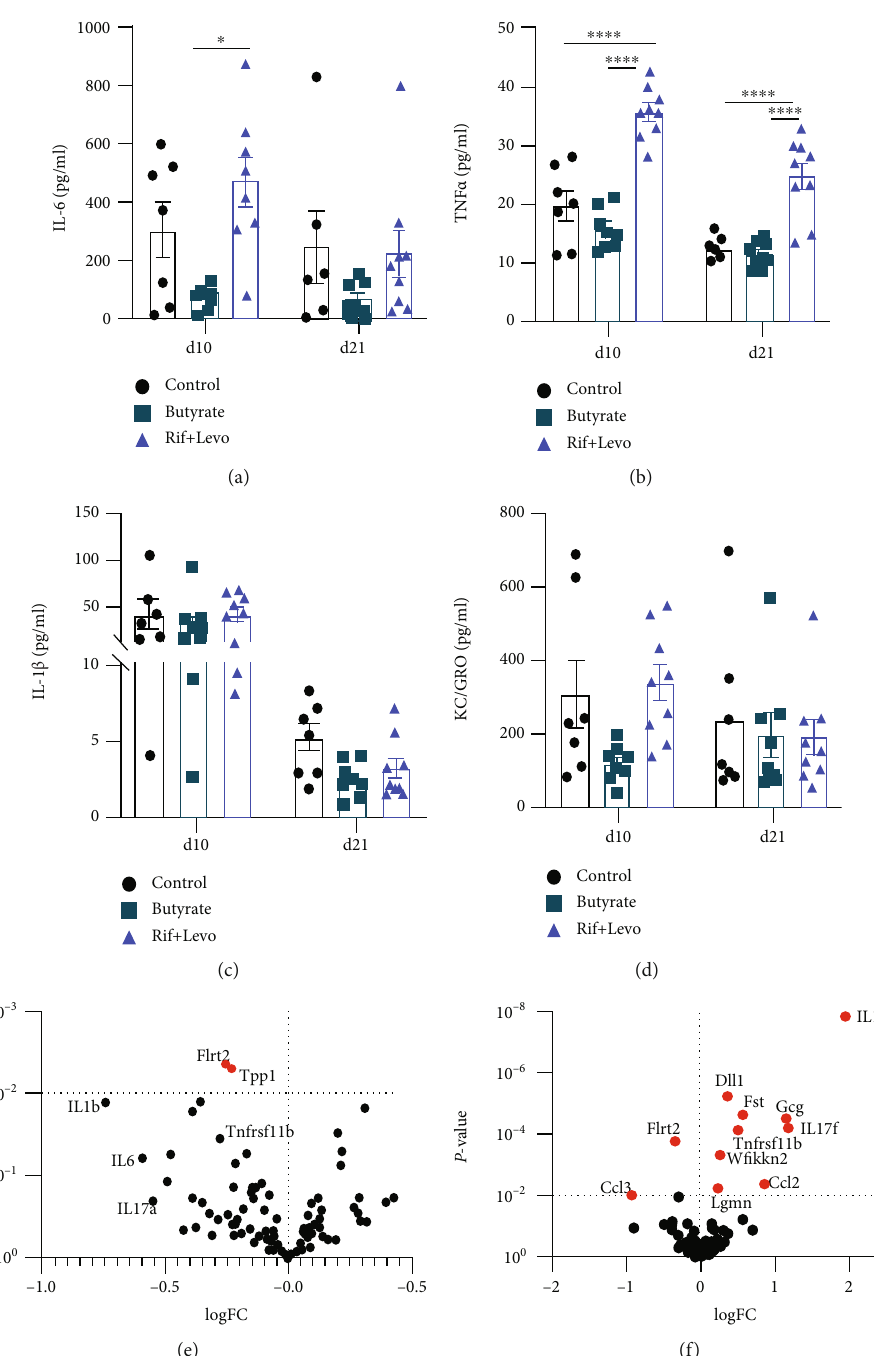
Figure 4: Butyrate induces a reduction of proin fl ammatory mediators, whereas rifampicin and levo fl oxacin increase proin fl ammatory and bone-preserving markers in serum. A variety of (pro-) in fl ammatory cytokines in serum of mice were assessed 10 days and 21 days following osteotomy using a multiplexed cytokine array and Olink targeted proteomics to investigate systemic biomarkers in serum of mice. Serum concentrations of (a) IL-6, (b) TNF α , (c) IL-1 β , and (d) of KC/GRO (murine IL-8 homologue) in the absence and presence of butyrate and Rif + Levo , respectively, 10 days and 21 days after osteotomy. Data shown are means ð n = 7 ‐ 9 Þ ± SEM . Di ff erential expression of 92 biomarkers in (e) butyrate-treated mice compared to control mice and in (f) Rif + Levo -treated mice compared to control mice. Signi fi cance threshold p < 0 : 01 . Signi fi cantly changed biomarkers are labelled in red. Flrt2 =leucine-rich repeat transmembrane protein; Tpp1=tripeptidyl-peptidase 1; Ccl3=C-C motif chemokine 3; Lgmn =legumain; W fi kkn2=WAP, Kazal, immunoglobulin, Kunitz, and NTR domain-containing protein 2; Tnfrsf11b =tumor necrosis factor receptor superfamily member 11B (osteoprotegerin); Ccl2=C-C motif chemokine 2; DII1 =delta-like protein 1; Fst=follistatin; Gcg =glucagon. ∗∗∗∗ p < 0 : 0001 ; ∗ p < 0 : 05